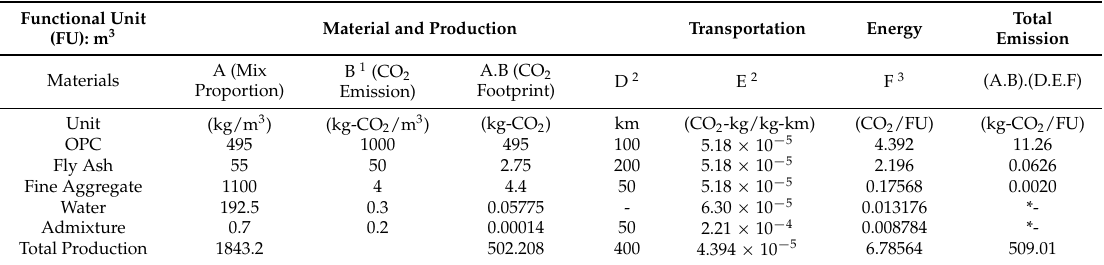
Table 8. Eco-points’ assessment for OPC + 10% fly ash compacting